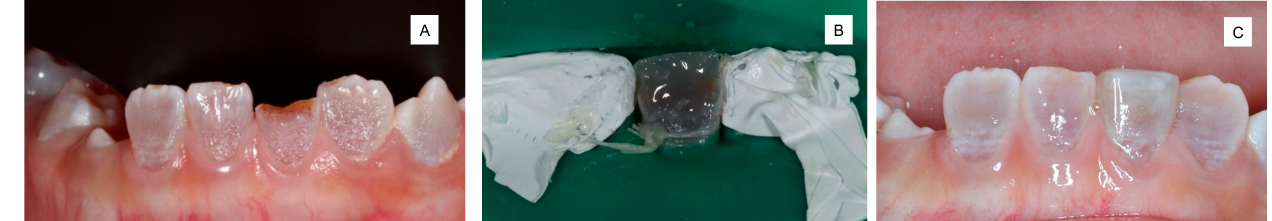
Figure 1. Example of using a composite mixed with a color modifier for restoring a severe tetracycline-induced discolored tooth. ( A ) A patient willing to restore the fracture of the lower left central incisor using direct resin composite; ( B ) resin composite mixed with the color modifier (grey shade), which was used to mimic the discolored dentin; ( C ) final outcome of the composite restoration that exhibits the natural appearance of the discolored